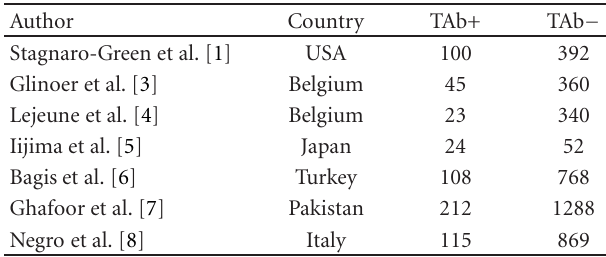
Table 1: Country of origin and number of women in each study of Figure